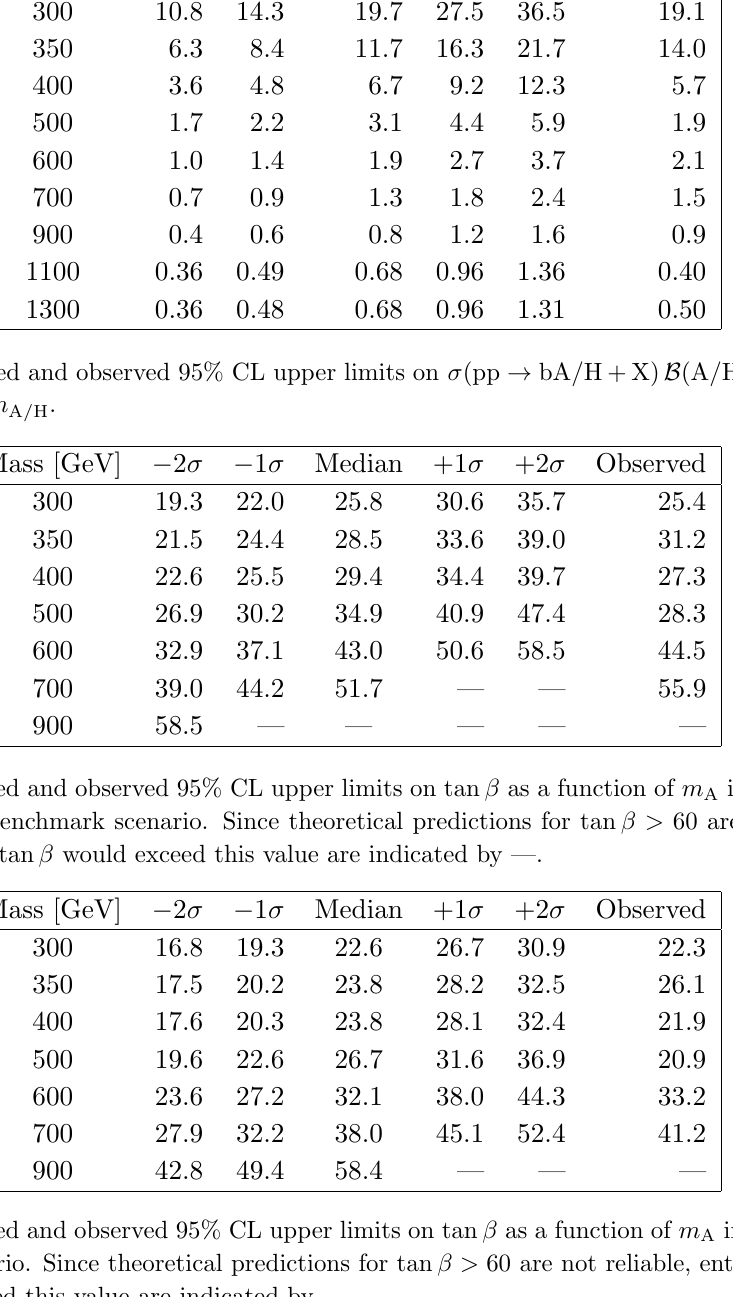
Table 3 . Expected and observed 95% CL upper limits on tan (cid:12) as a function of m A in the hMSSM benchmark scenario. Since theoretical predictions for tan (cid:12) > 60 are not reliable, entries for which tan (cid:12) would exceed this value are indicated by